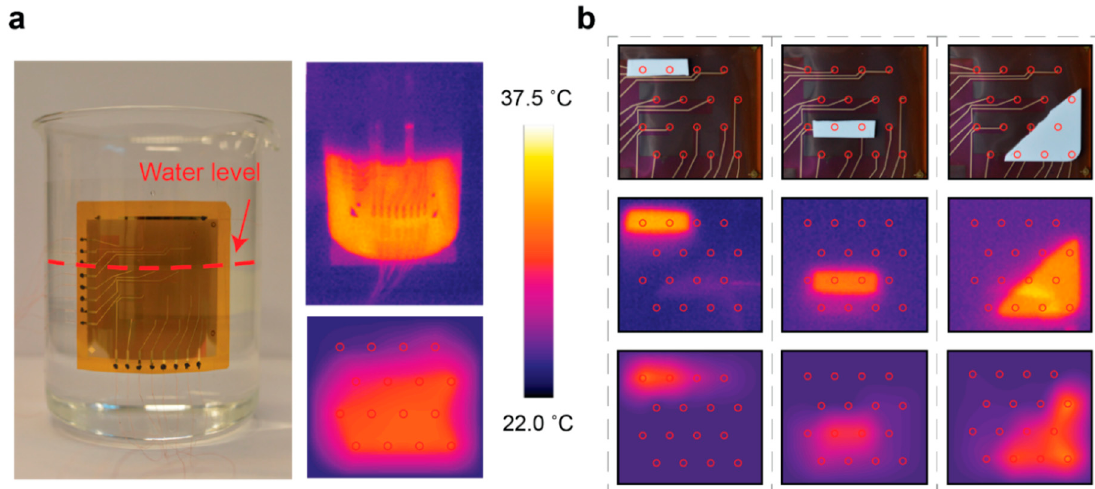
Figure 3. ( a ) Device conformally attached onto a beaker surface with a radius of 5.25 cm along with a temperature distribution map of the beaker partly filled with 36 °C water. ( b ) Device on a flat surface with heated ceramic pieces on the active area ( top row ) along with heat distribution maps produced by infrared camera ( middle row ) and the presented thermal distribution sensor ( bottom row ). The pixel locations in the four-by-four matrix are highlighted as red dots.